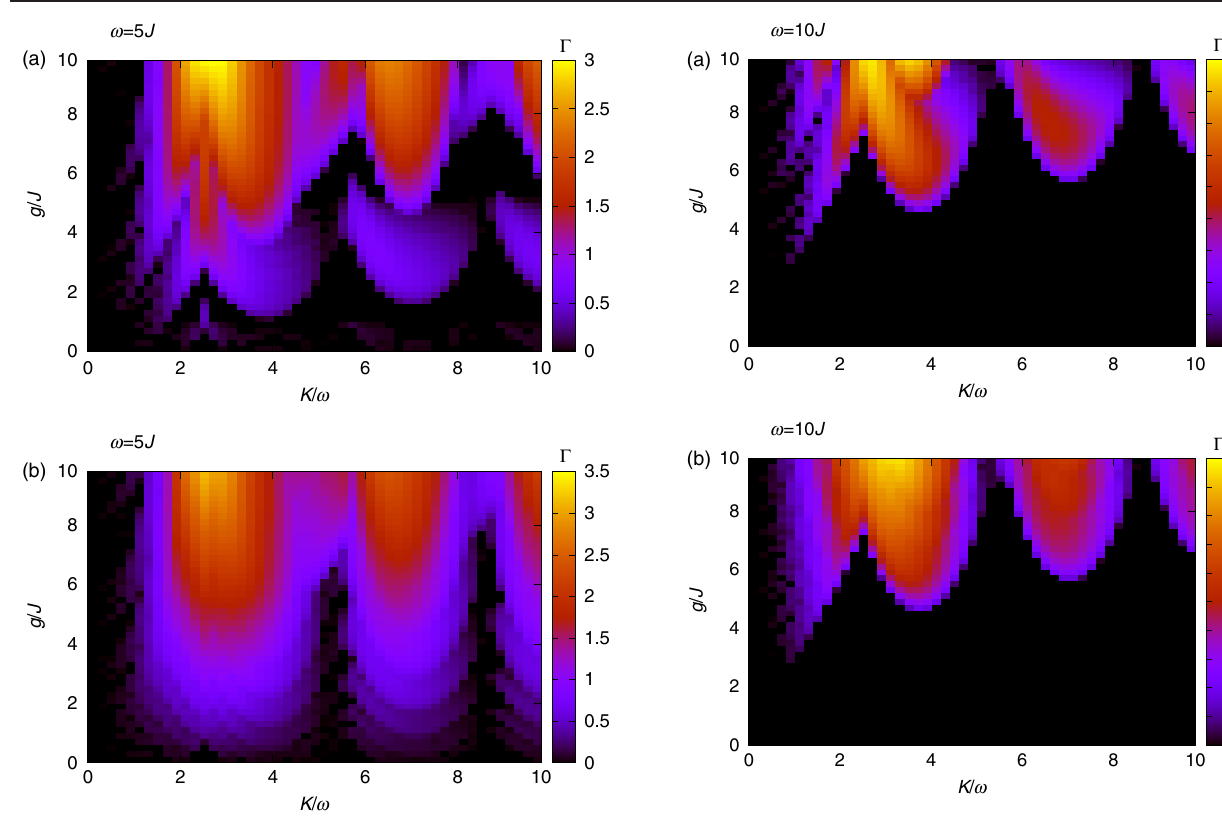
FIG. 12. Analytical instability rate as a function of interaction strength g ¼ U ρ and modulation amplitude K= ω , for ω ¼ 10 J (i.e., outside the low-frequency regime) and for two different numbers of lattice sites in the transverse direction: N 4 (top panel) and 16 (bottom panel). This figure is to be compared panel) and N y ¼ y ¼ with Fig.